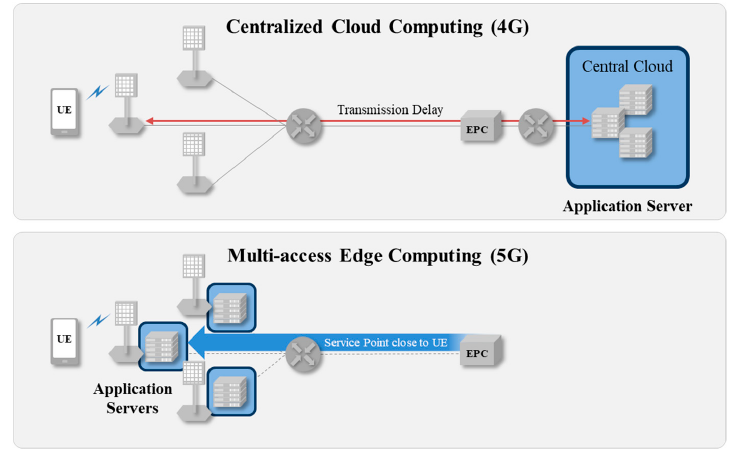
Figure 1. Centralized Cloud Computing (CCC) and Multi-access Edge Computing (MEC) architectures.